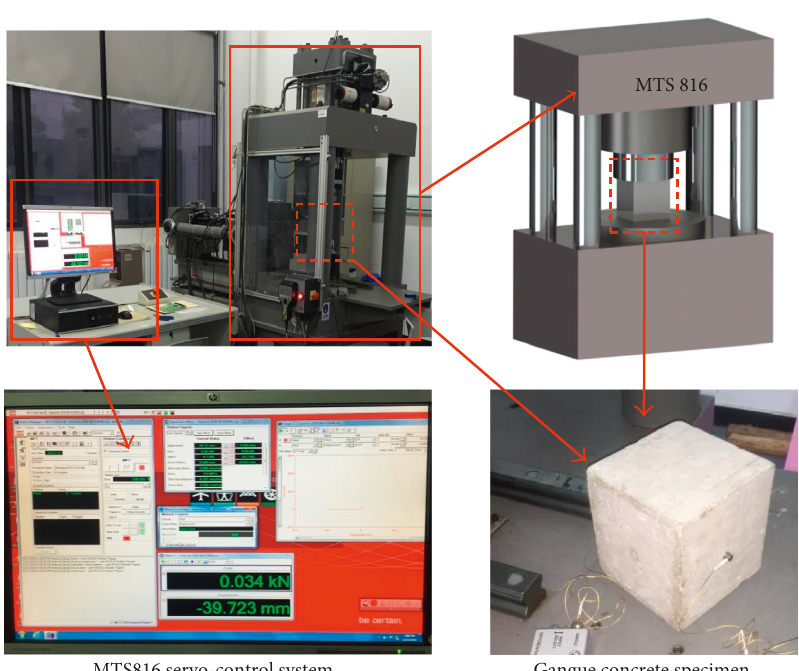
Figure 3: Test system and formed